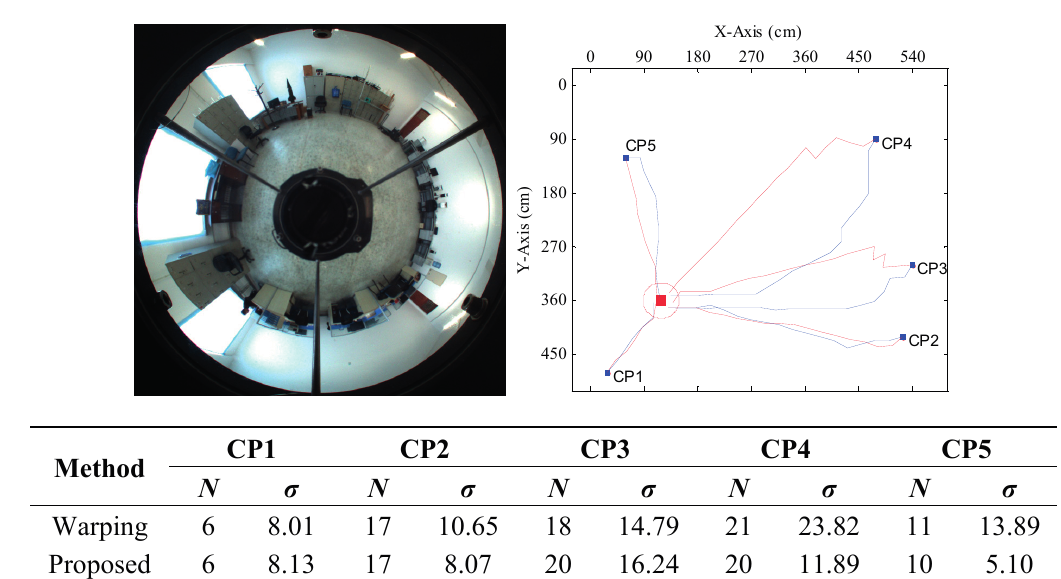
Figure 13. Robot homing Trial 2.